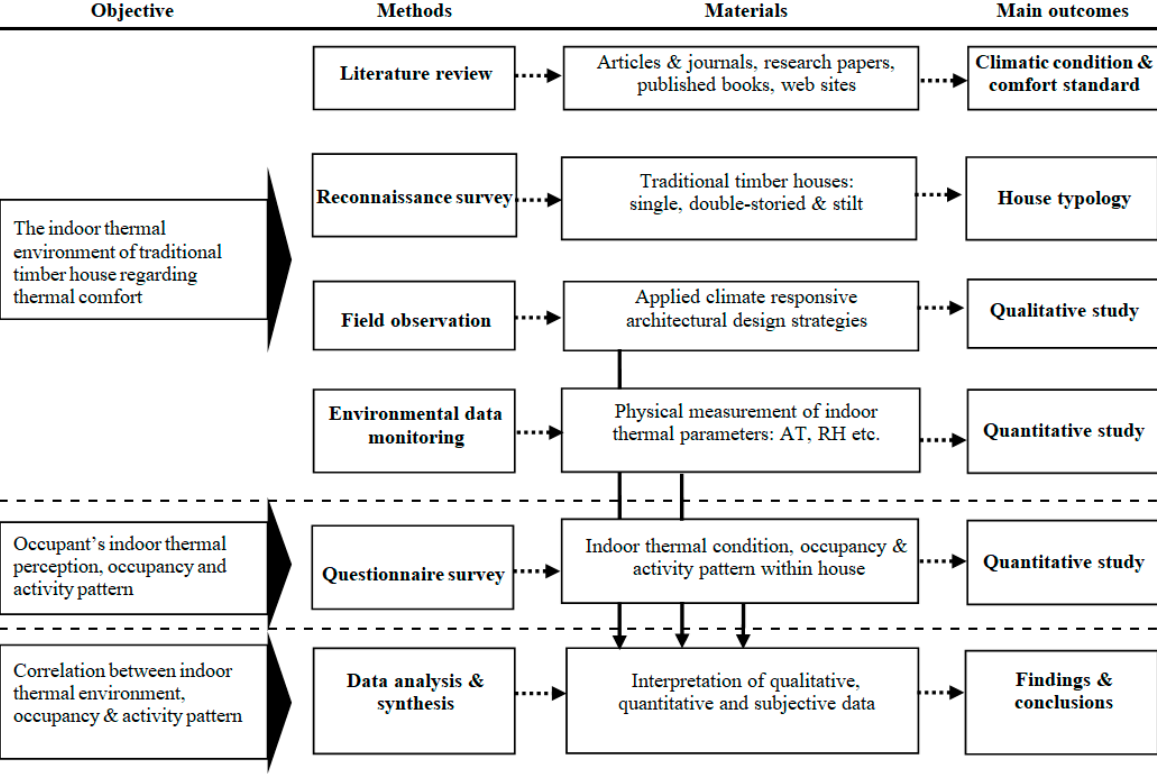
Figure 2. Structure of the study.